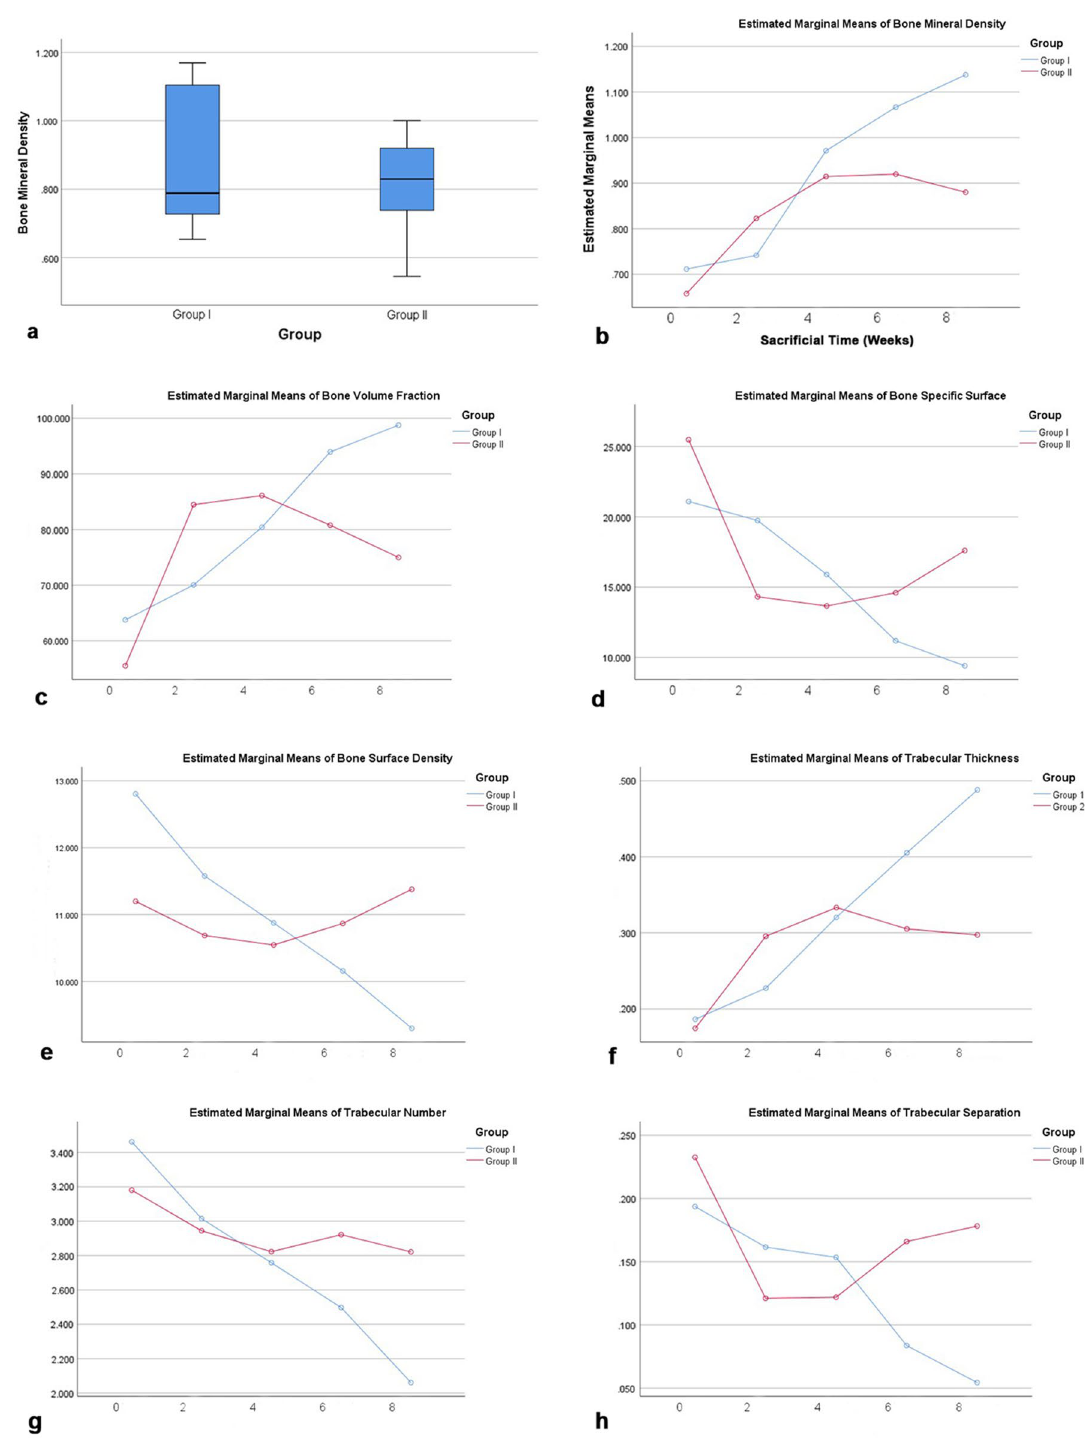
Figure 5. Changes in BMD and other bone morphometry parameter values over time in IP BRONJ model groups I and II. Group I shows higher BMD than group II ( a ). Group I shows a constant elevation of BMD compared with group II ( b ). Group I shows constant elevation in BV/TV ( c ) and Tb.Th. ( f ) and constant reduction in BS/BV ( d ), BS/TV ( e ), Tb.N. ( g ), and Tb.Sp. ( h ) compared with group II, in which the BP was stopped